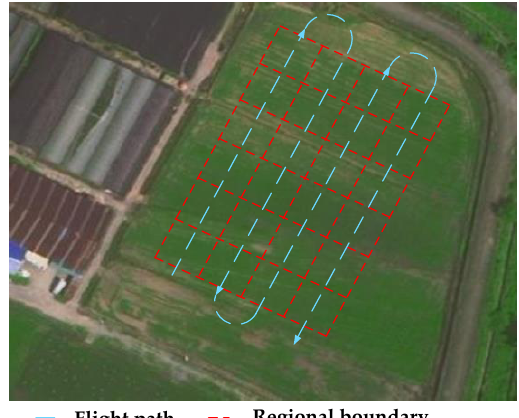
Figure 2. Sketch map of target plot.